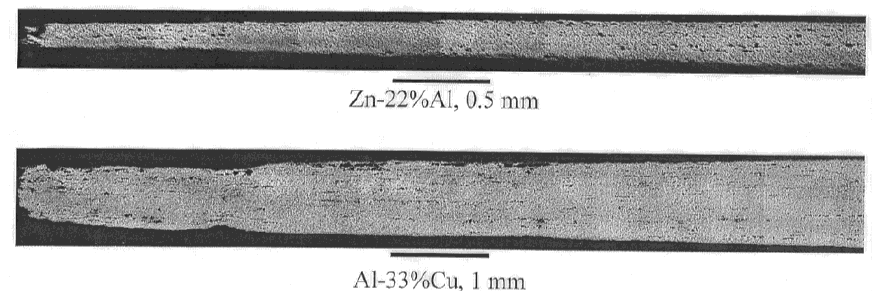
Figure 9. Cavity stringers in superplastic